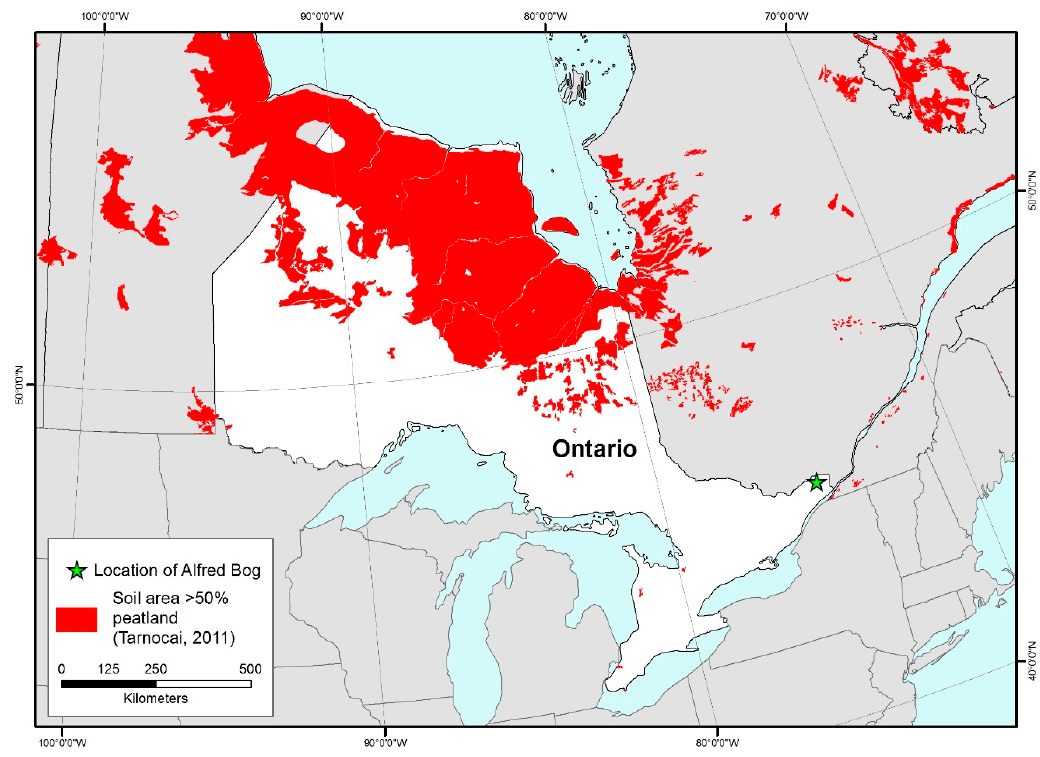
Figure 1. Study area within Ontario, Canada. Red areas show the extent of peat soils (from Tarnocai et al. [35]), and the green star indicates study site.